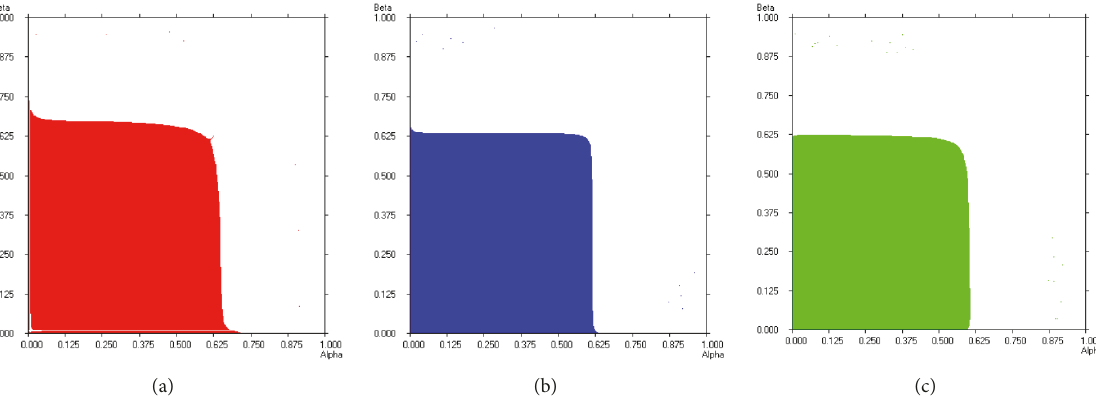
Figure 4: (a) The stability with 𝛼 and 𝛽 is changed, and 𝛾 = 0.25 ; 𝑟 31 = 𝑟 32 = 0.1 . (b) The stability with 𝛼 and 𝛽 is changed, and 𝛾 = 0.25 and 𝑟 = 𝑟 = 0.5 . (c) The stability with 𝛼 and 𝛽 is changed, and 𝛾 = 0.25 and 𝑟 31 32